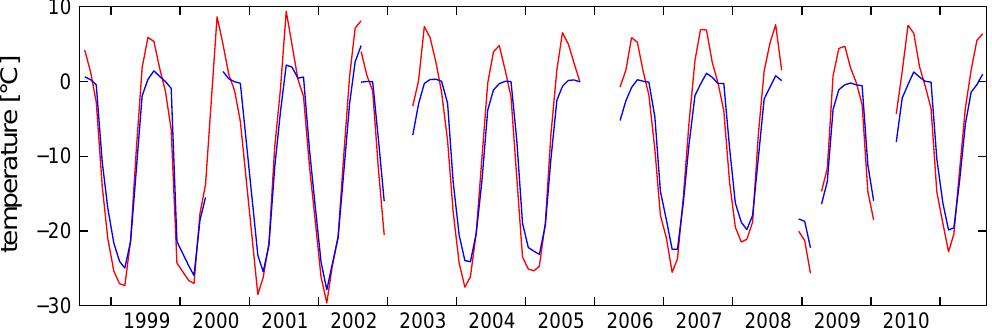
Fig. 10. Record of mean monthly soil temperatures for active layer at polygon rim site on Samoylov Island, 1998–2011. Red line from 1998– 2002 is from a sensor depth of 0.09m, and from 2002–2011 is from a sensor depth of 0.06m. Blue line from 1998–2002 is from a sensor depth of 0.47m and from 2002–2011 is from a sensor depth of